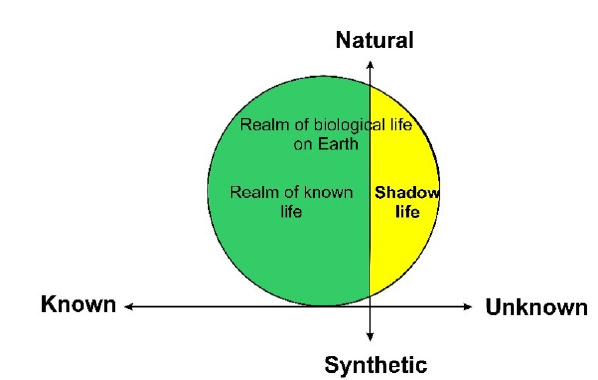
Figure 4. Shadow biosphere concept depicted as an estranged life hidden amongst the Earth biosphere Until today, the possible and closest way to find the estranged hidden life on Earth is by unravelling the mysterious realm of the extremophile organisms. Microbial extremophiles sometimes appear very